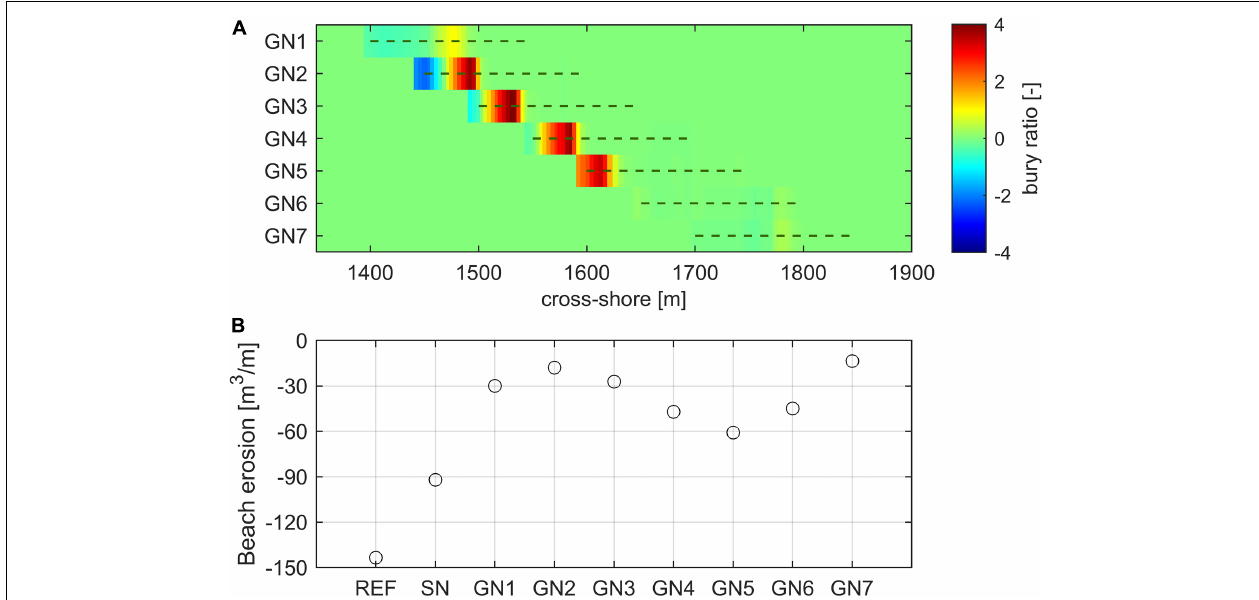
FIGURE 8 | The bury ratio of green nourishment (A) and beach erosion under 100 days mild wave condition for all cases (B) .